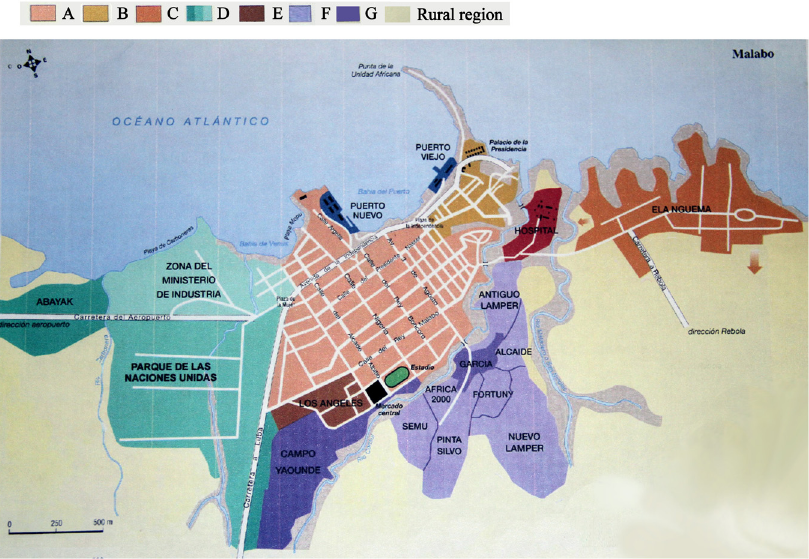
Fig 1. The geographic location of our research population. Malabo city was divided into eight regions including the old city center (A), the presidential office and residential area (B), the public residential area from previous planning (C), the modern residential area with a low population density (D), the modern residential area with a high population density (E), the un-planned residential area with a different population density (F) and the un-planned residential area with a high population density (G). The rural area included Luba, Moka, Riaba and Baney on Bioko